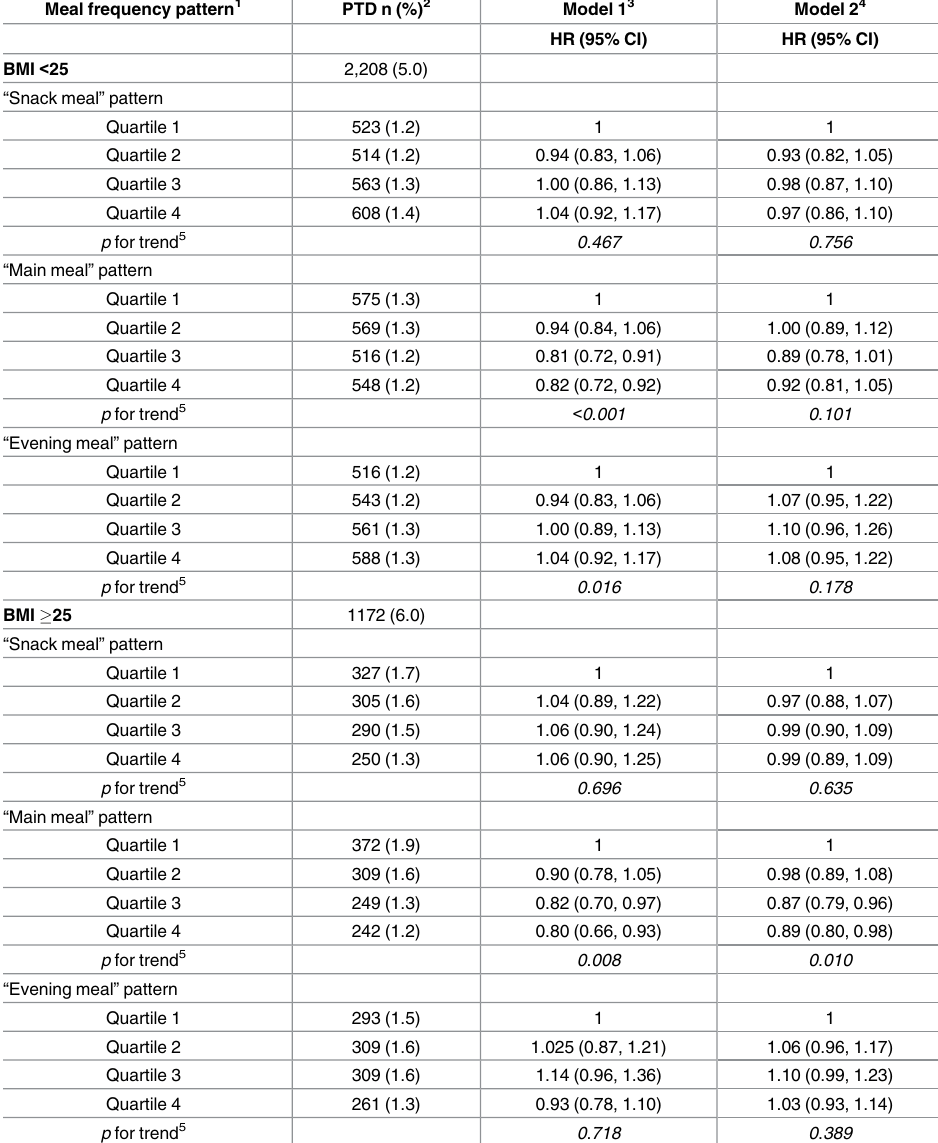
Table 4. Associations between meal frequency patterns and preterm delivery in 65,487 pregnant women in the Norwegian Mother and Child Cohort Study (MoBa), stratified based on